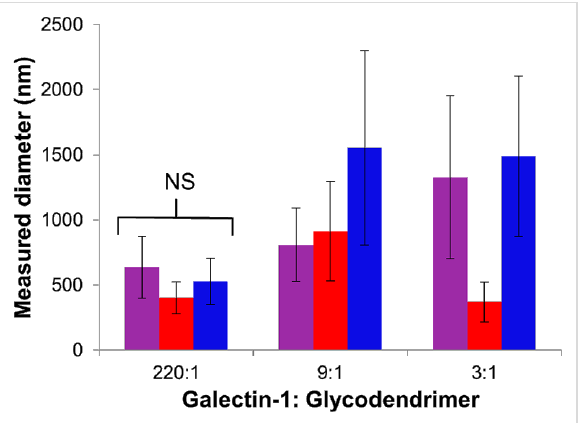
Figure 3: Average diameter (nm) of multivalent galectin-1 nanoparti- cles formed with multivalent glycodendrimers. For compounds 2 (purple), 3 (red), and 4 (blue), nanoparticle diameter (nm) was measured upon the addition of 0.18 µM glycodendrimer for 220:1, of 4.5 µM glycodendrimer for 9:1, and of 13 µM glycodendrimer for 3:1 to 40 µM galectin-1. NS represents non-significant difference in aggre- gate size measured for all generations determined by ANOVA.